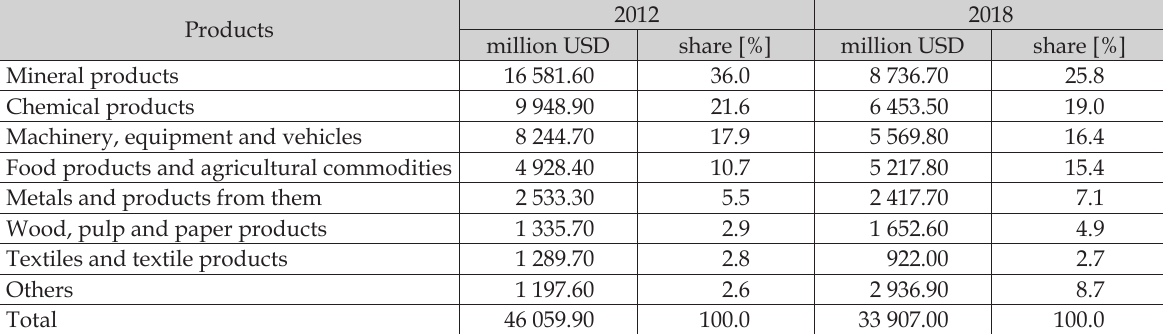
Table 2. Commodity structure of goods exports of the Republic of